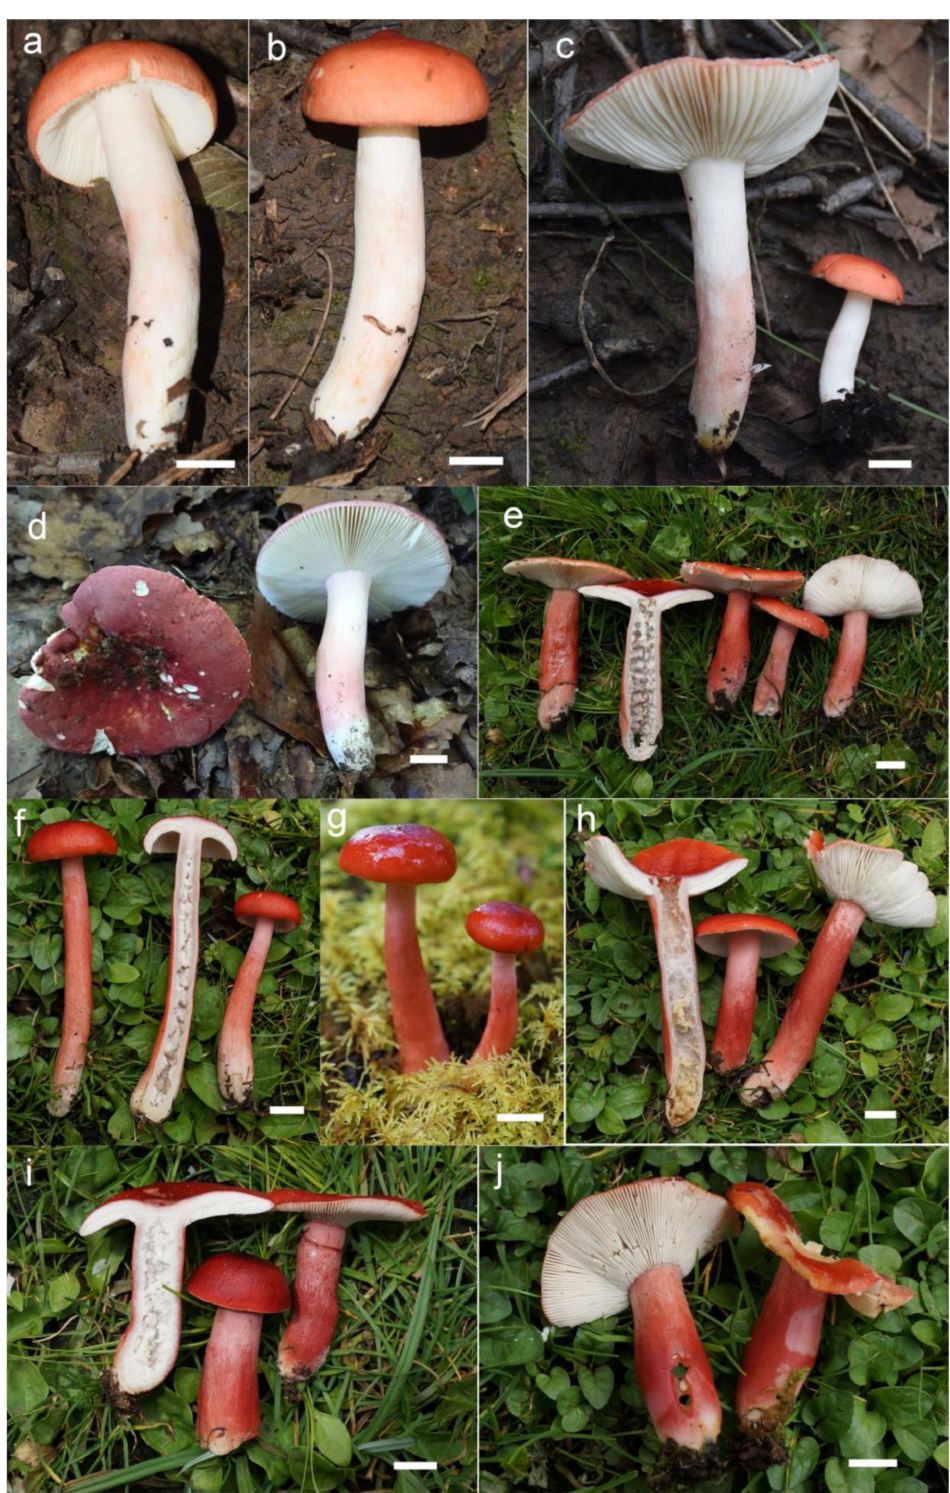
Figure 3. Basidiomata. ( a – d ) Russula begonia . ( e – j ) R. roseola . Bars: 10